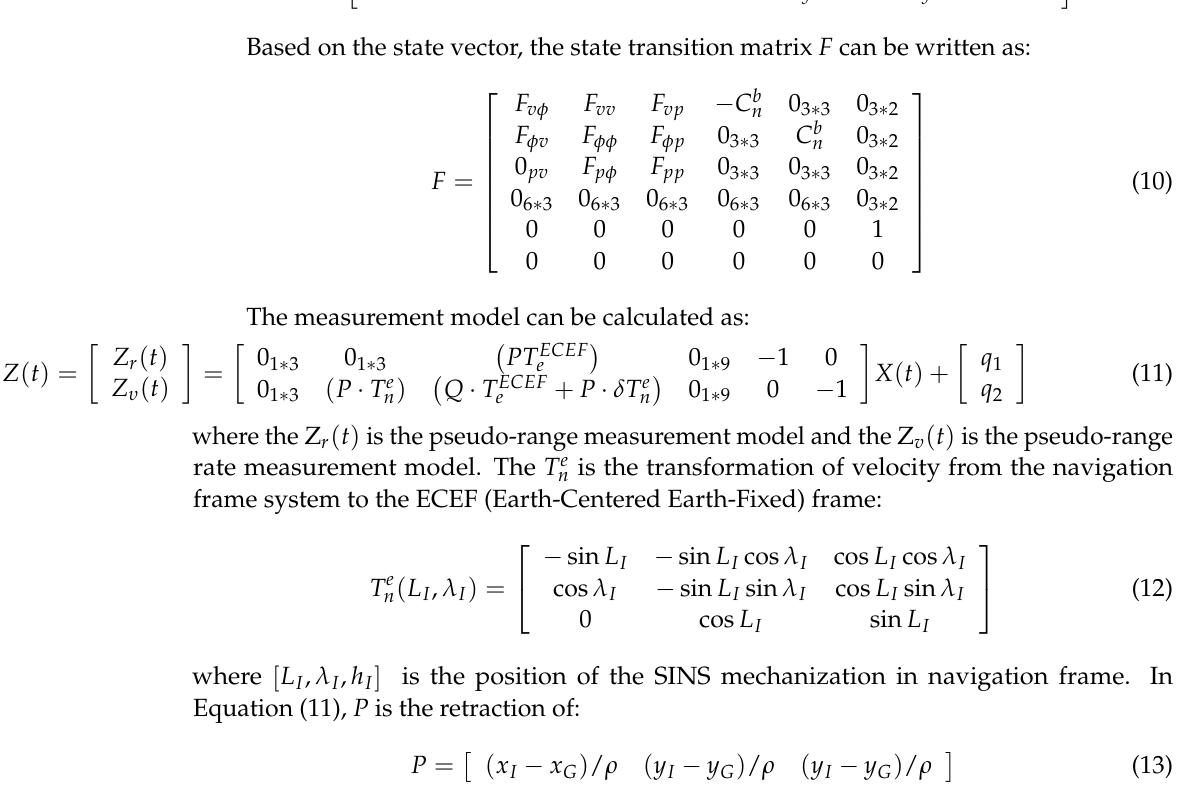
where X(t) is the error-state vector of SINS, F(t) is the state transition matrix, r is the vector of process noise, q is the vector of measurement noise, Z(t) is the vector of measurement, and H(t) is the observation matrix constructed based on pseudo-range and pseudo-range rate. As expressed in (2), the state vector X has 17 dimensions, which are composed of 3-dim attitude errors, 3-dim velocity errors, 3-dim position errors, 3-dim gyroscope drifts, 3-dim accelerometer drifts, 1-dim pseudo-range error, and 1-dim pseudo-range rate error: